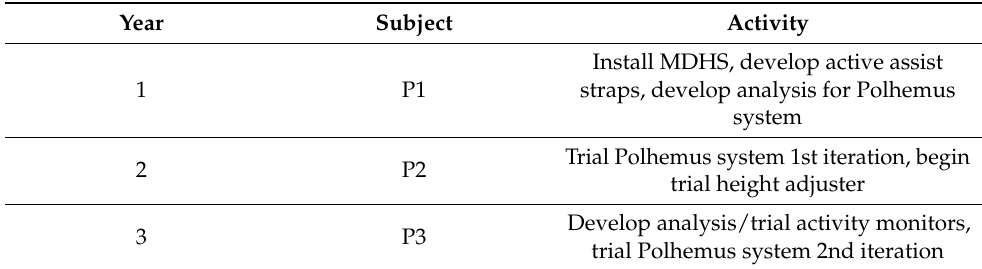
Table 1. Summary of development of MDHS with wearable